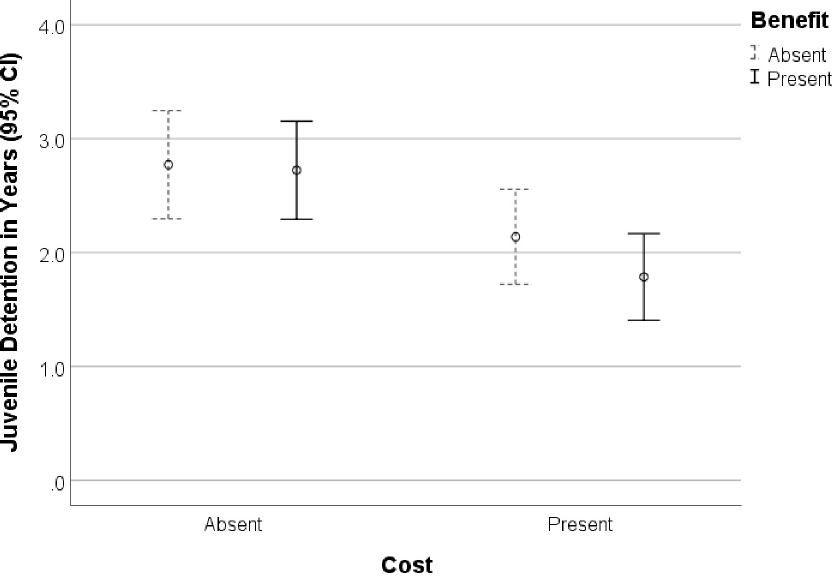
Fig 1. Sentence recommendations were lower following exposure to information about the cost of incarceration relative to no cost information ( p < .001), but sentence recommendations with and without exposure to benefit information did not differ from one another ( p = .348), nor was there a cost-by-benefit interaction ( p = .478).